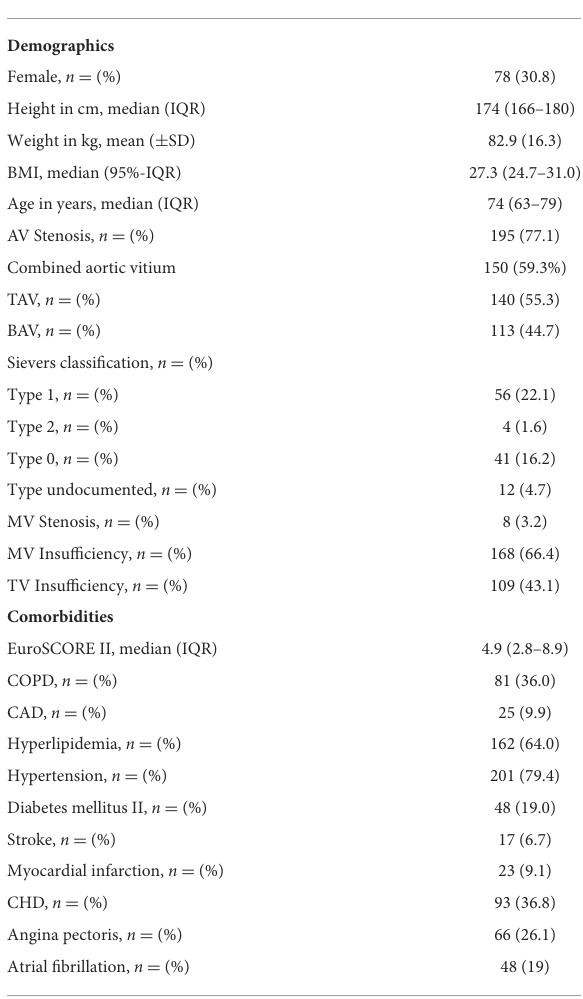
TABLE 1 Patient and surgical baseline characteristics of the study